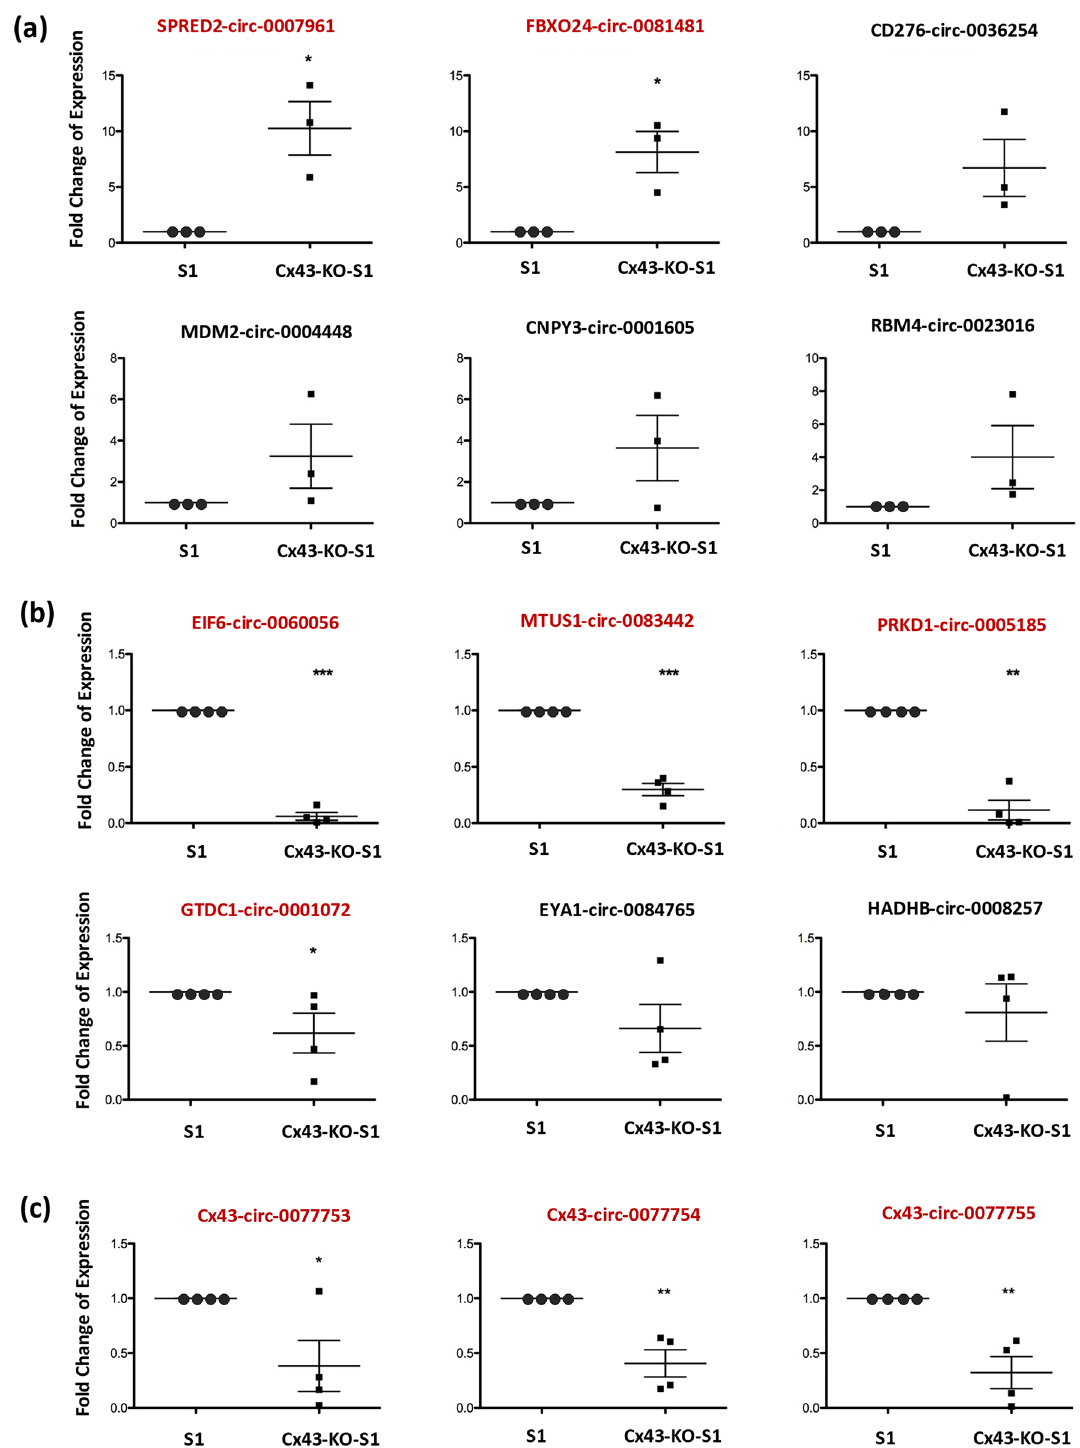
Figure 3. RT-qPCR validated nine significant differentially expressed circRNAs in the cultured epithelia. Four replicates of Cx43-KO-S1 and four replicates of S1 cells were plated in Matrigel for 11 days. Total RNA was extracted and RT-qPCR was performed in Cx43-KO-S1 versus S1 breast epithelial cells in 3D using 18S ribosomal RNA as an endogenous control for ( a ) the selected up-regulated circRNAs and ( b ) the selected down-regulated circRNAs and ( c ) the three Cx43 ( GJA1 ) derived circRNAs as per microarray results. Dot plot represents the mean fold change with the standard error of mean as error bars of each circRNA expression in the breast epithelial acini in 3D. The circRNAs highlighted in red font were confirmed to be significantly dysregulated in Cx43-KO-S1 as compared to S1 cells in 3D. *denotes p < 0.05 and **denotes p < 0.01 and *** denotes p < 0.001 for Cx43-KO-S1 versus S1 cells using one-tailed unpaired